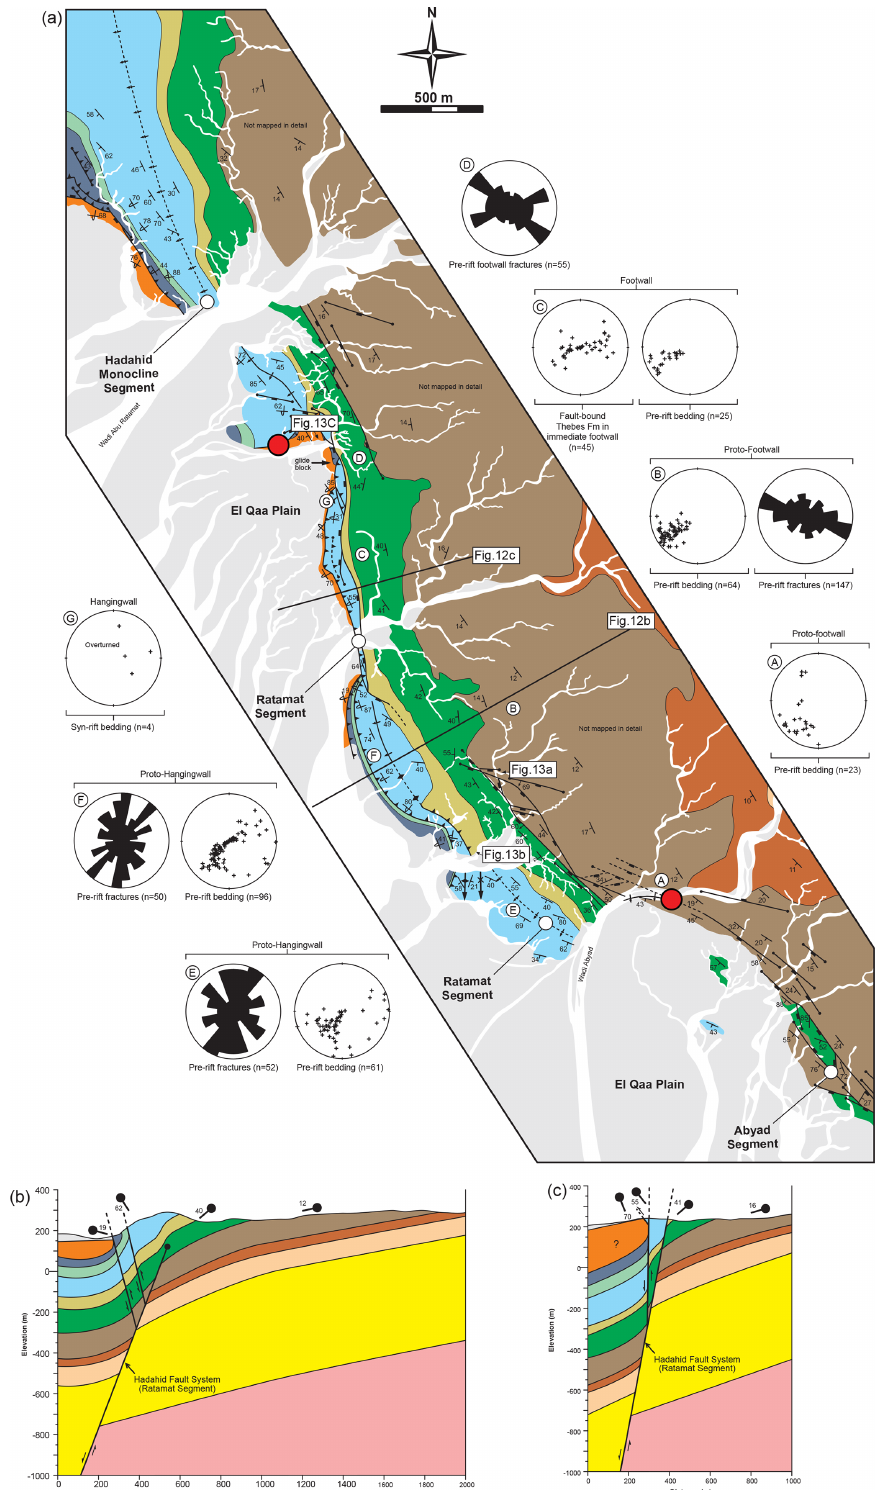
Figure 12. (a) Field map of the Ratamat Segment of the Hadahid Fault System. Colour key to stratigraphic units is shown in Fig. 3a. Red dots indicate the approximate boundaries between the identified segments. Lower-hemisphere projection stereonets summarize the dip and dip direction of pre- and syn-rift bedding ( a–g ; location shown on map). Rose diagrams show the trend of fractures in pre-rift strata. The location of the photograph shown in Fig. 13 and the cross sections shown in (b) and (c) are indicated. (b) Down-plunge cross section across the central part of the Ratamat Segment. (c) Down-plunge cross section across the northern part of the Ratamat